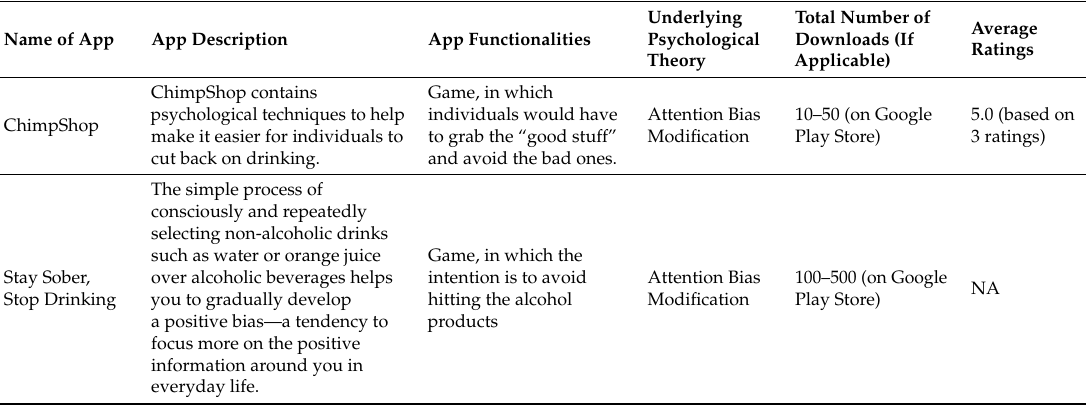
Table 2. Applications identified from commercial application stores that have basis on a psychological theory.